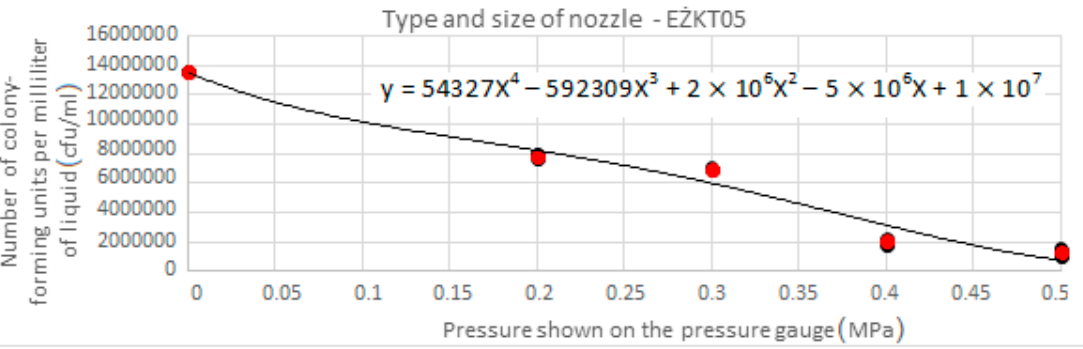
Figure 11. The influence of pressure on survival of cfu/mL of liquid for EŻKT04.